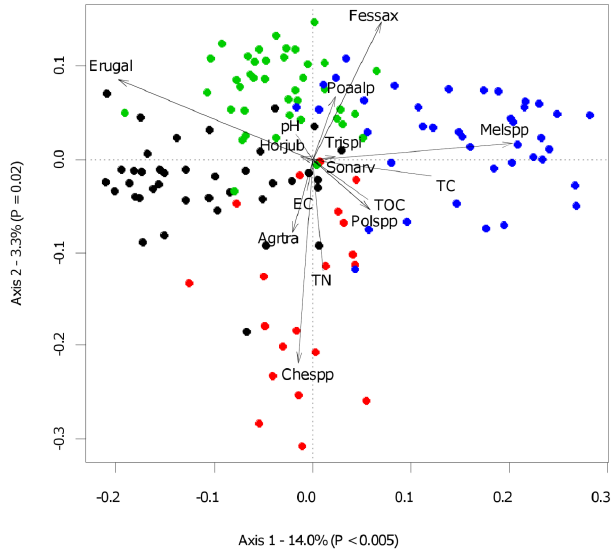
Fig. 4. Triplot of effect of standardized soil properties (lines) on Figure 4. Triplot of effect of standardized soil properties (lines) on Hellinger transformed Hellinger transformed species plant density (arrows). Species codes species plant density (arrows). Species codes are the first three letters of genus are the first three letters of genus and species names. Plots at each site are in different dot colours: site New, black; site New HM, red; and species names. Plots at each site are in different dot colours: site New black, site Old, green; and site Plant, blue. Other soil parameters in the site New HM red, site Old green and site Plant blue. Other soil parameters in the figure are hydrogen ion concentration (pH), total organic carbon figure are hydrogen ion concentration (pH), total organic carbon (TOC) and (TOC) and electrical conductivity electrical conductivity (EC).